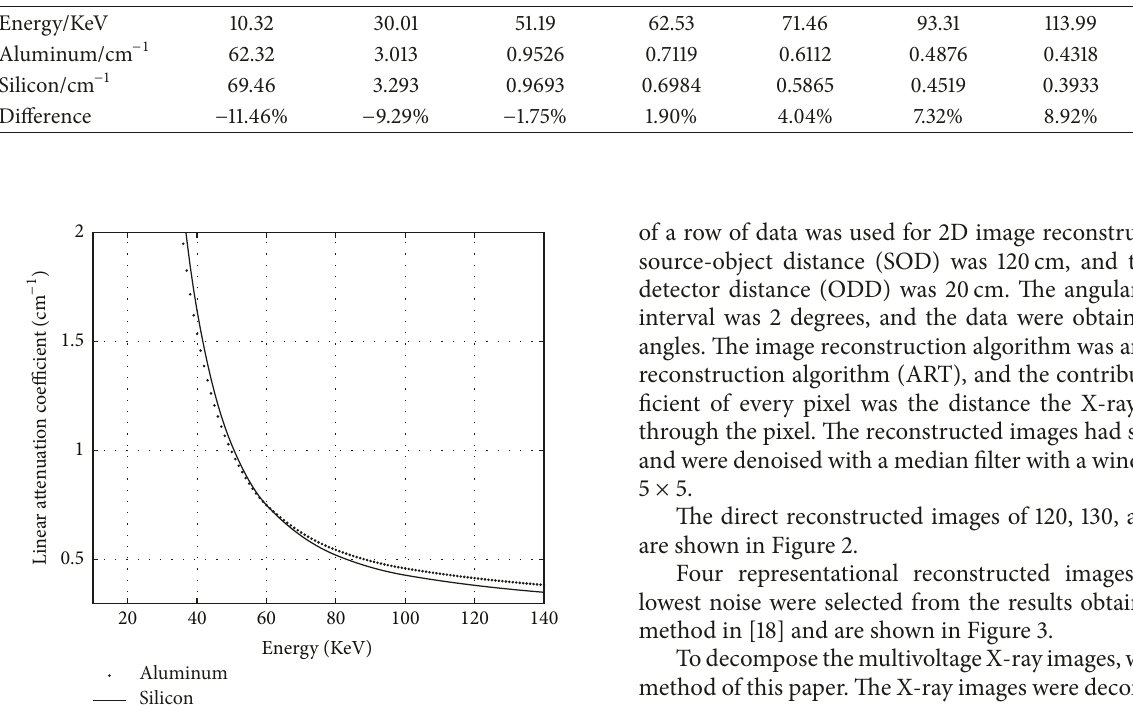
Table 1: Some origin values of NIST and difference of the linear attenuation coefficient of aluminum and silicon.